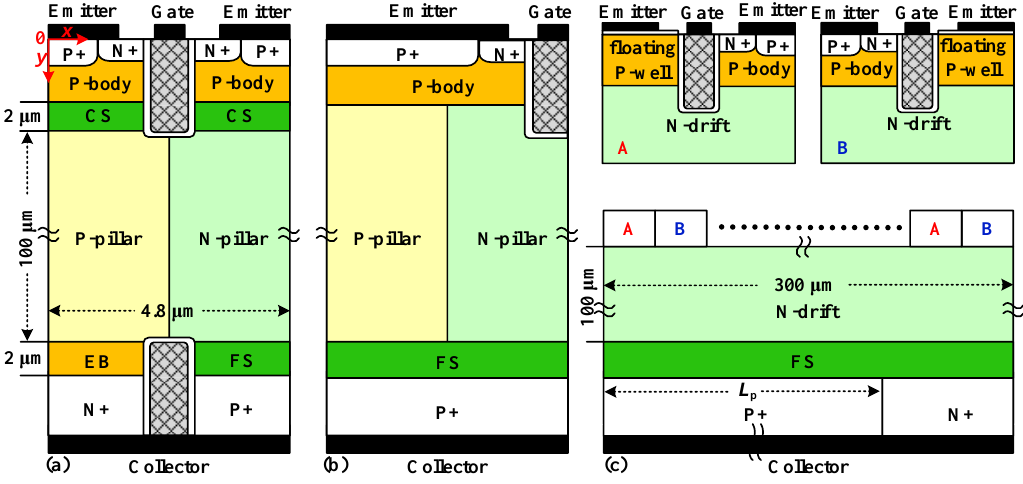
Figure 1. Schematic cross-sections of ( a ) SJ-RC-IGBT, ( b ) SJ-IGBT, and ( c ) CRC-IGBT. The cell-unit width of SJ-RC-IGBT and SJ-IGBT is 4.8 µm and of CRC-IGBT is 300 µm.